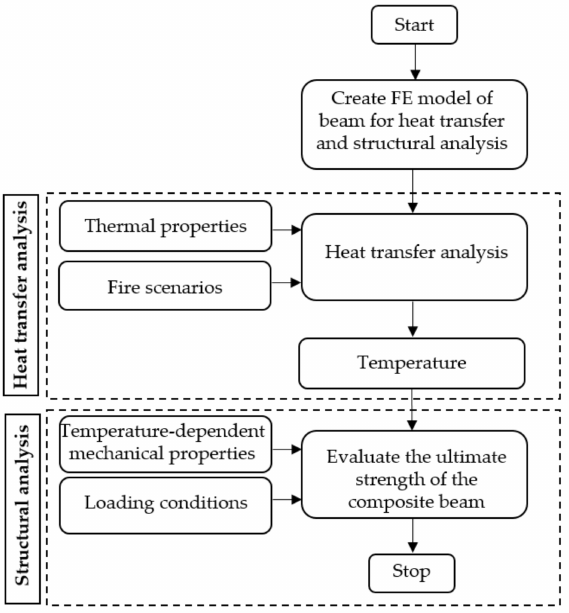
Figure 2. Chart of two steps in undertaking ultimate strength